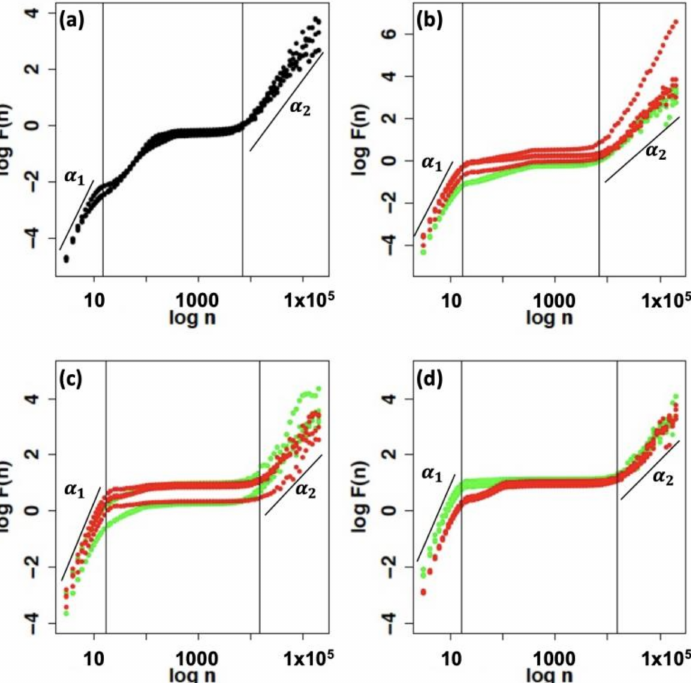
Figure 5. Fluctuation functions ( F ( n ) ) of bearing vibration signals (48,000 samples/s): ( a ) normal (black), ( b ) minor (green), and severe (red) ball faults, ( c ) minor (green) and severe (red) inner race faults, ( d ) minor (green) and severe (red) outer race